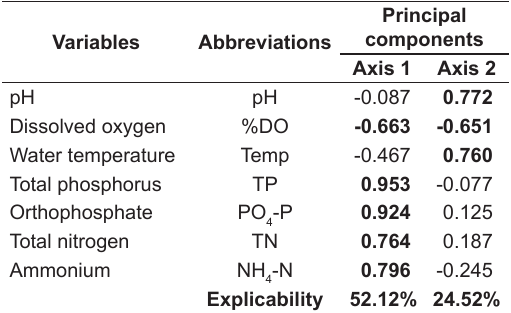
Figure 3. Ordination biplot by Principal Component Analysis (PCA) of the sample units generated from seven environmental variables. Where: the hours of collection correspond to the numbers 10 (10:00h), 13 (13:00h), 16 (16:00h), 19 (19:00h), 22 (22:00h), 1 (01:00h), 4 (04:00h) and 7 (07:00h); the lines ( convex hull ) join the cloud represented by the hours in which the samples were taken at each point: affluent (blue), fingerlings (red), juveniles (green) and adults (purple); Temp = water temperature; %DO = saturation percentage of dissolved oxygen; TP = total phosphorus; PO -P = orthophosphate; TN = total nitrogen; NH -N = ammonium. 4 4 Table 2. Pearson correlation coefficients between the variables and the first two axes of PCA (bold values correspond to the variables that had the greatest correlation with the axes, above